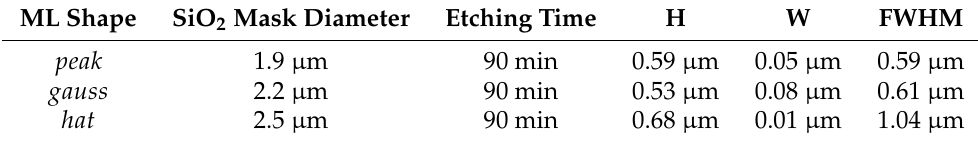
Figure 2. Simulation of light extraction efficiency η of a QD (at Z = 0.396 µ m) in a ML, as a function of QD horizontal position X ( a ) and wavelength ( b ); ( c ) typical YZ-cut profile electric field distribution in a ML ( η is given), W: the ML vertical position from the top AlGaAs DBR, the optimal W is 0.116 µ m ( gauss ), 0.012 µ m ( hat ) and 0.080 µ m ( peak ); statistics on QD exciton emission peak intensity ( d ) and wavelength ( e ) in a total of 176 spectral lines, 34 in the flat sample and 142 in different shaped MLs; ( f ) typical µ PL spectra of QDs in the hat - and gauss -shaped ML, offset vertically for clarity: MLs are fabricated in the dilute QD region (left) or the multi-QD region (right); ( g ) auto-correlations of the dominant peaks in the hat -shaped MLs hat -1 and hat -2, with radiative lifetimes extracted from their photon autocorrelation, 0.3 ns for hat -1 and 0.6 ns for hat -2, red: deconvolution fitting, blue: convolution fitting. Table 1. Detailed fabrication parameters and shape parameters of the three shapes of